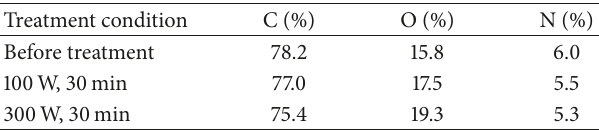
Table 2: The element contents of PI surface before and after surface modification with 1.0g/L TiO 2 dispersed solution under different UV